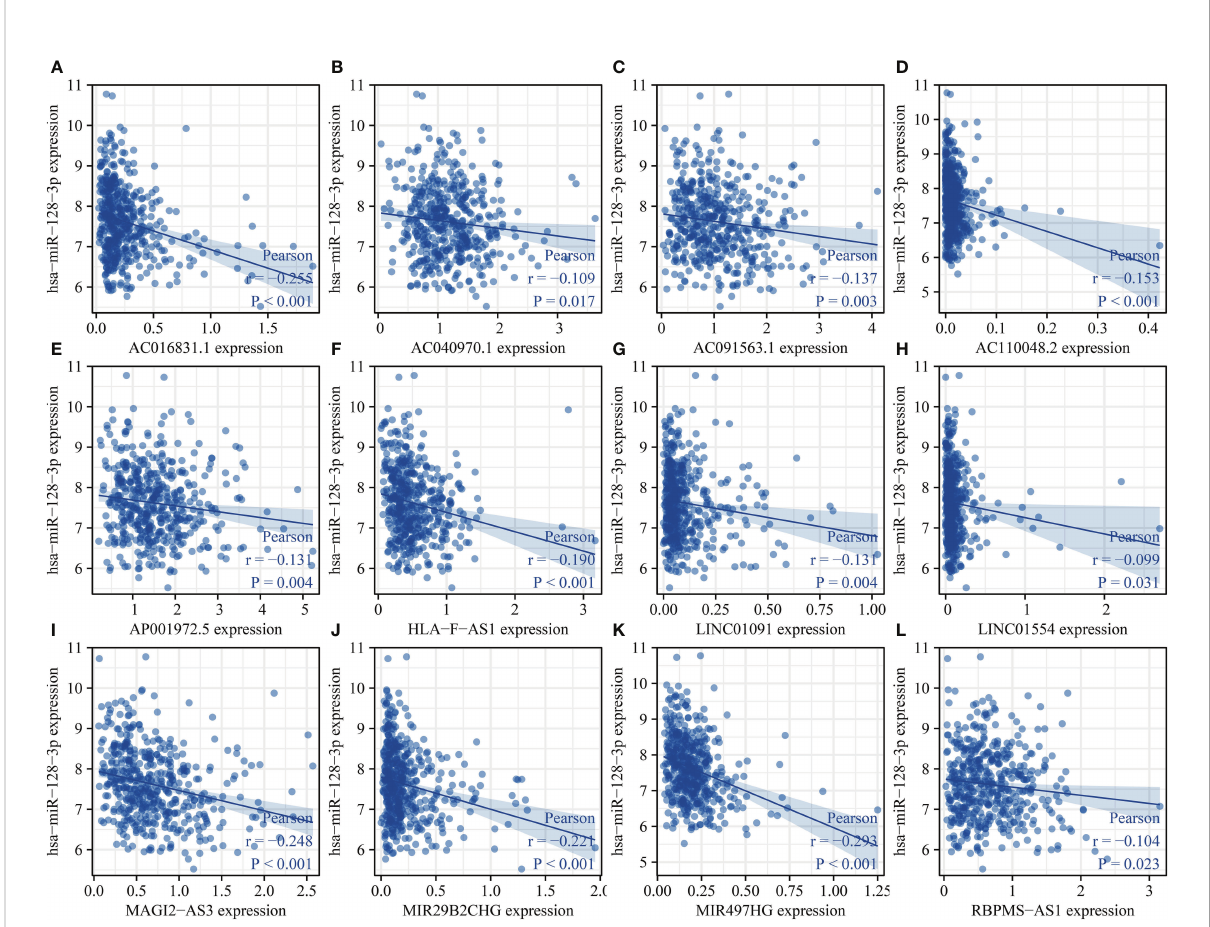
FIGURE 14 miR-128-3p expression level was associated with the lncRNA expression level in LUSC. (A) AC016831.1; (B) AC040970.1; (C) AC091563.1; (D) AC110048.2; (E) AP001972.5; (F) HLA-F-AS1; (G) LINC01091; (H) LINC01554; (I) MAGI2-AS3; (J) MIR29B2CHG; (K) MIR497HG; (L) RBPMS-AS1. LUSC, lung squamous cell